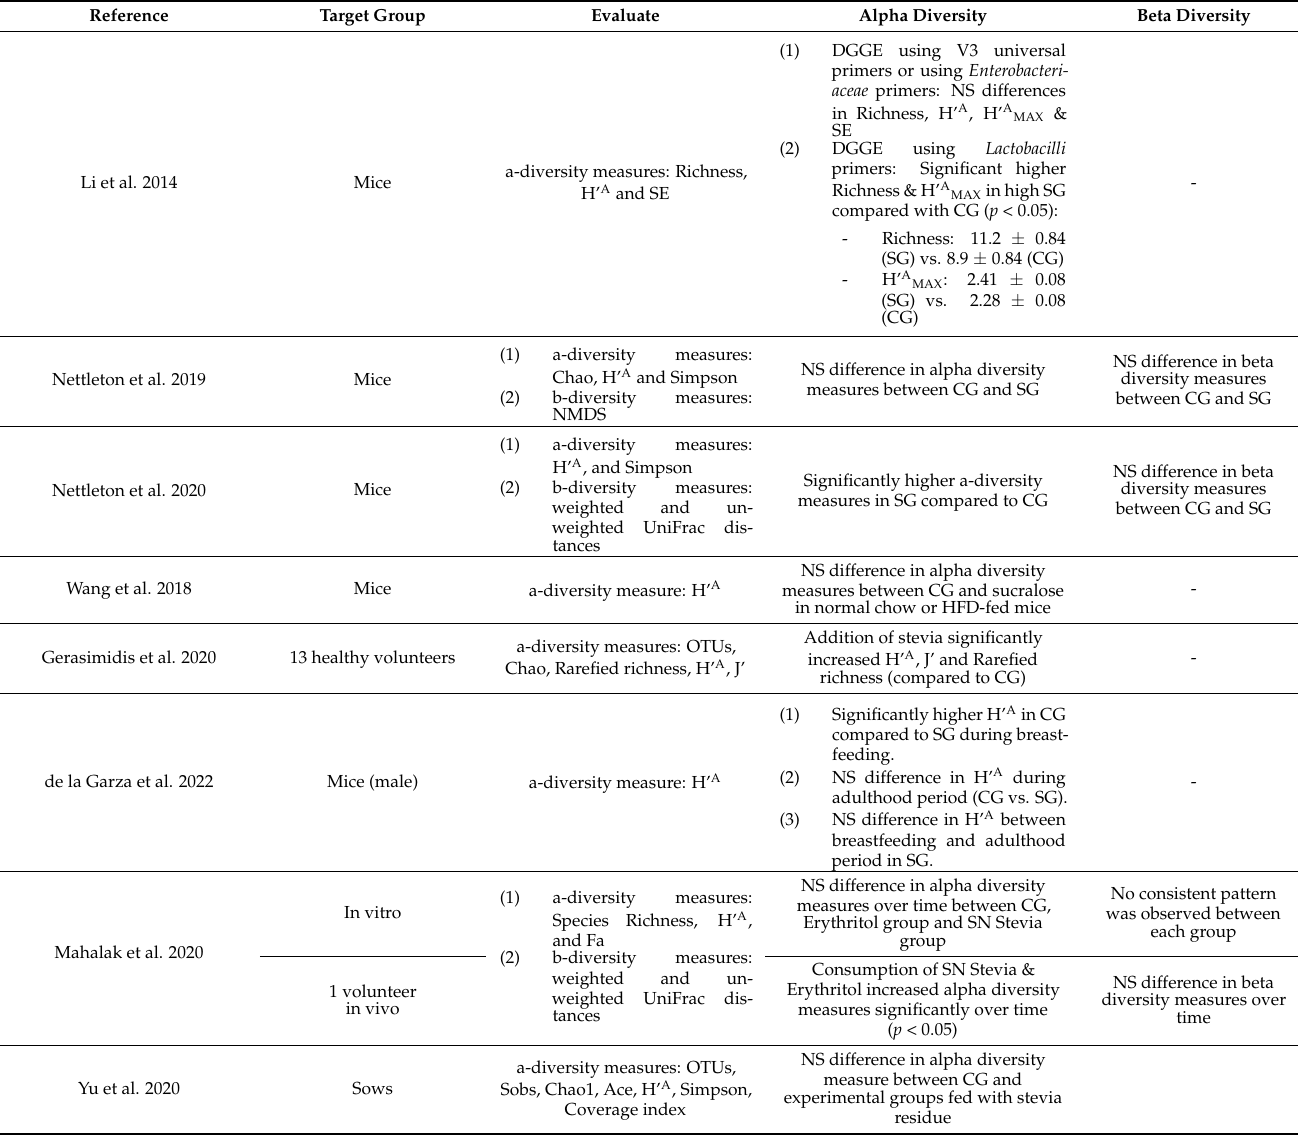
Table 3. The effects of stevia and steviol glycosides on microbial